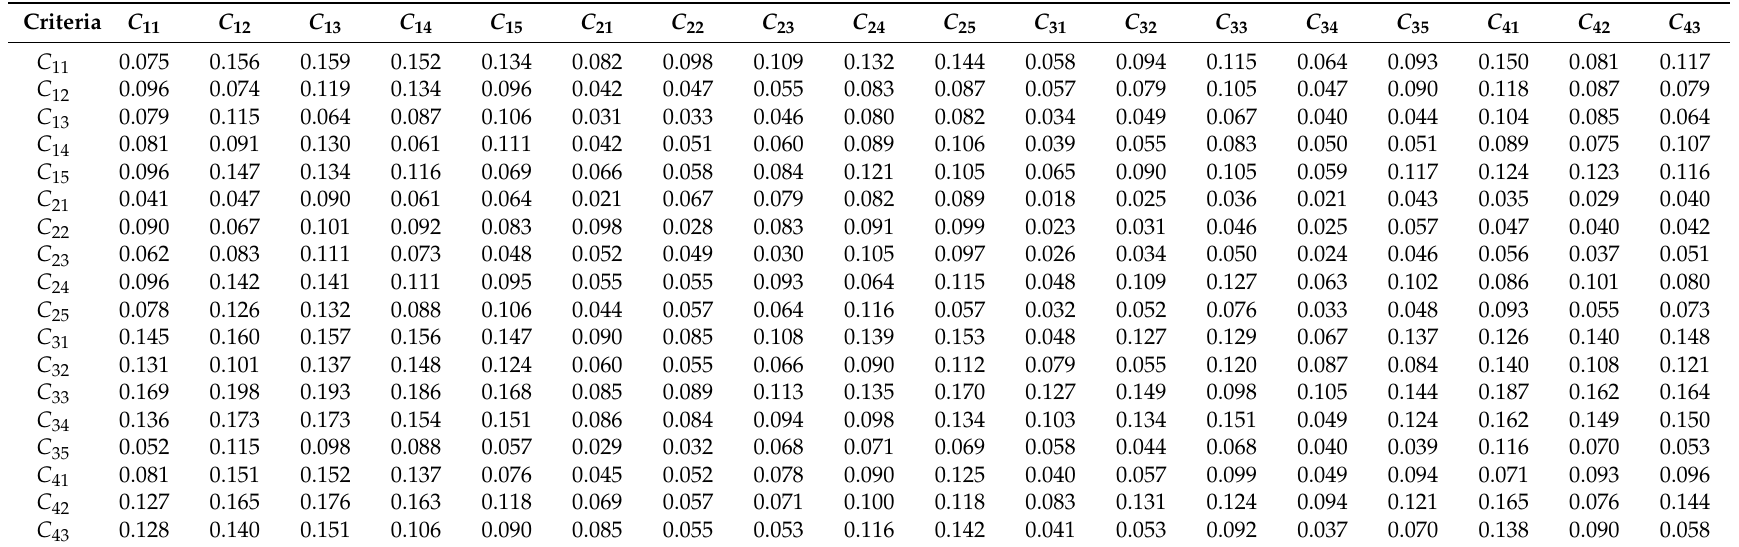
Table A2. The total influence matrix of criteria T C .